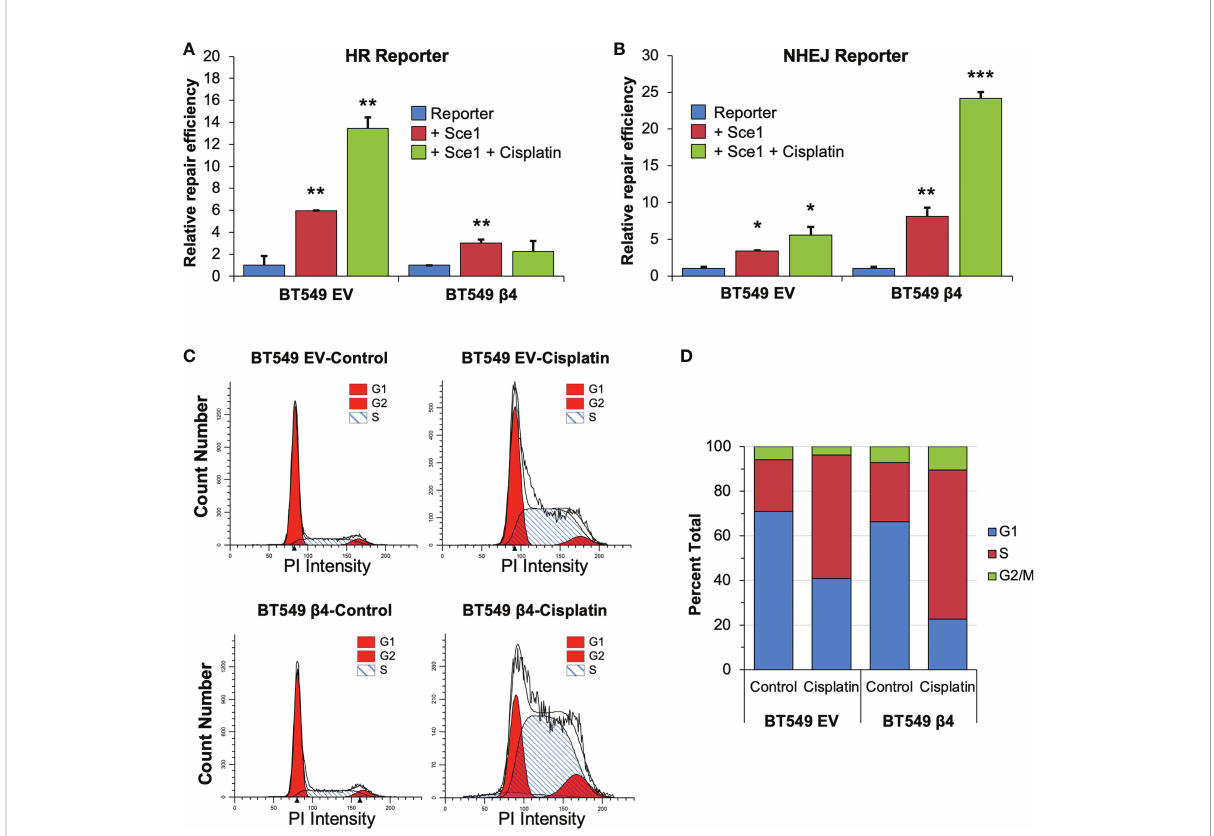
FIGURE 5 Integrin a 6 b 4 signaling enhances NHEJ and suppresses HR. BT549 cells (EV, b 4) were electroporated with pDRGFP (HR reporter; A) or pimEJ5GFP (NHEJ reporter; B) in the presence or absence of pCBASce-I plasmid, which expresses I-SceI endonuclease that causes DSB, plus pmCherry as a transfection control. After cells were plated on laminin-1-coated plates and treated with 5µM cisplatin for 48h, cells were analyzed GFP positive cells by fl ow cytometry using cotransfected pmCherry as a transfection control to determine relative repair ef fi ciency (A, B) . (C, D) BT549 cells (EV, b 4) plated on laminin-1 coated plates were treated with 10µM cisplatin for 24h and assessed for cell cycle distribution using propidium iodide staining and fl ow cytometry analysis. Representative (C) and averaged (D) cell cycle distributions are shown. Data are representative of 3 experiments. *p < 0.05, **p < 0.001, ***p <